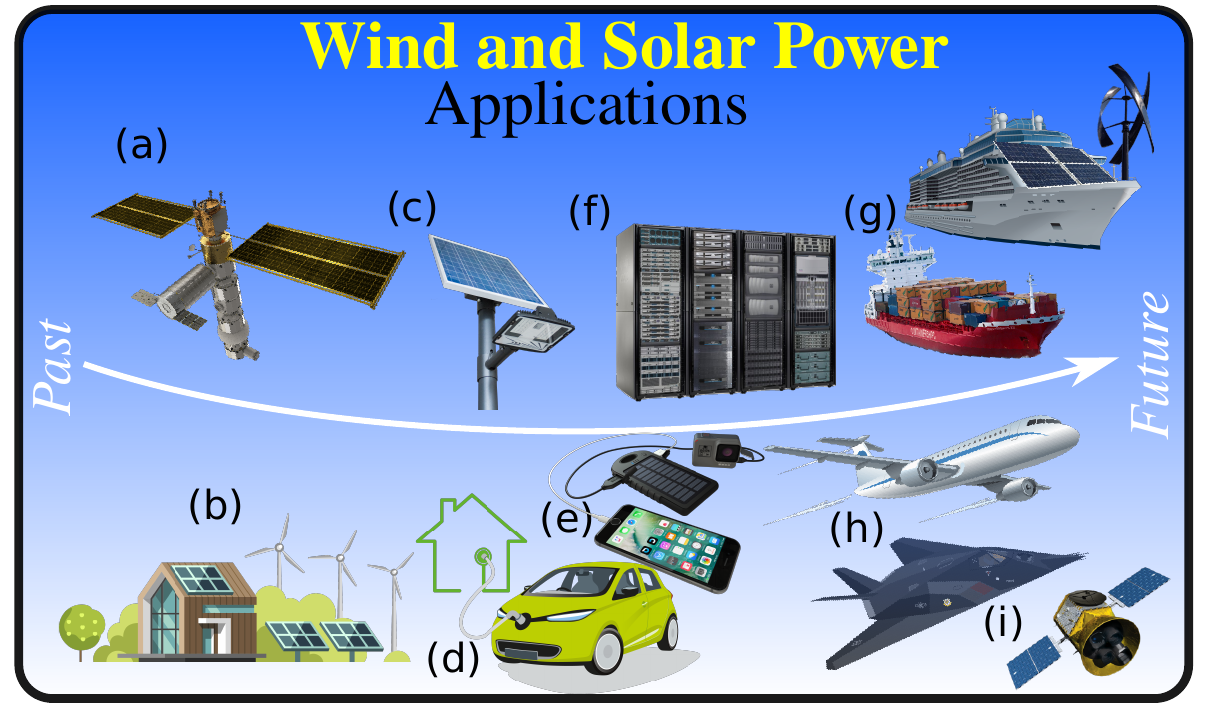
Figure 1. Different sectors of wind and solar power renewable energy technology applications. ( a ) space; ( b ) buildings; ( c ) civil engineering; ( d ) automobile; ( e ) smart devices and surveillance; ( f ) data centers; ( g ) marine industry; ( h ) civil and military defence aerospace industries; ( i ) future aerospace